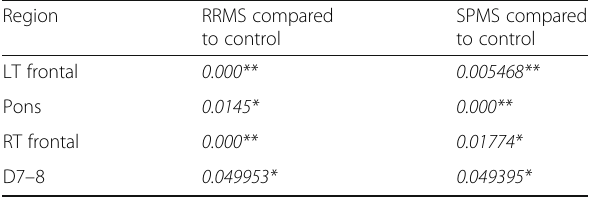
Table 1 P value of FA decrease per region Region RRMS compared to control